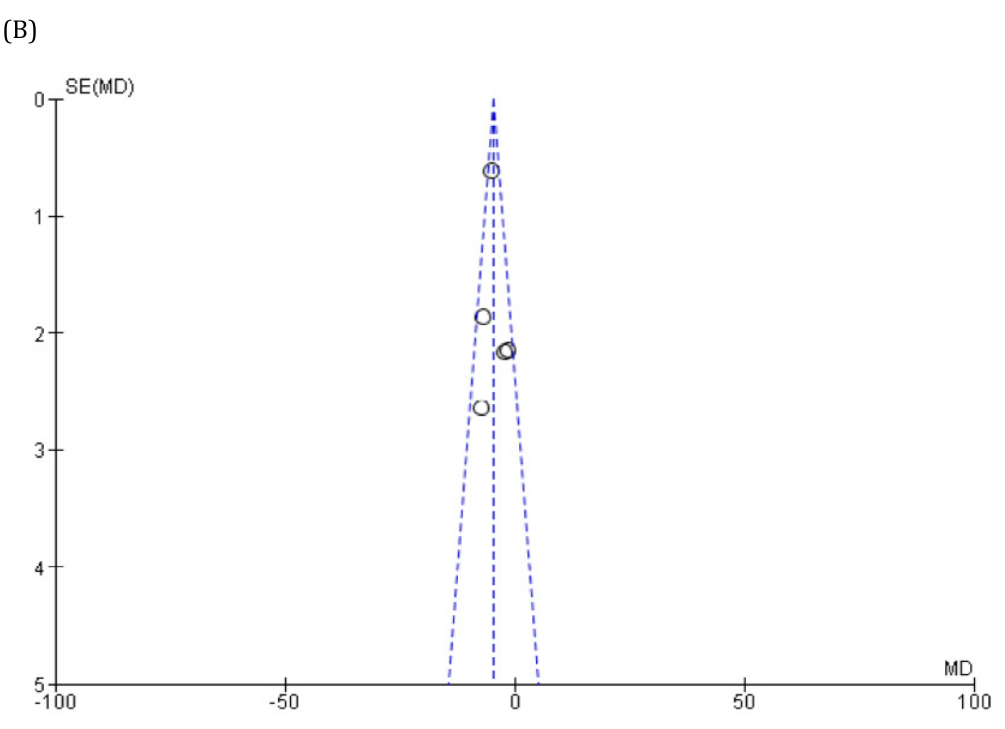
Figure 3 – Funnel chart for the effects of resistance training on blood pressure of hypertensive older adults: (A) systolic blood pressure (SBP); (B) diastolic blood pressure